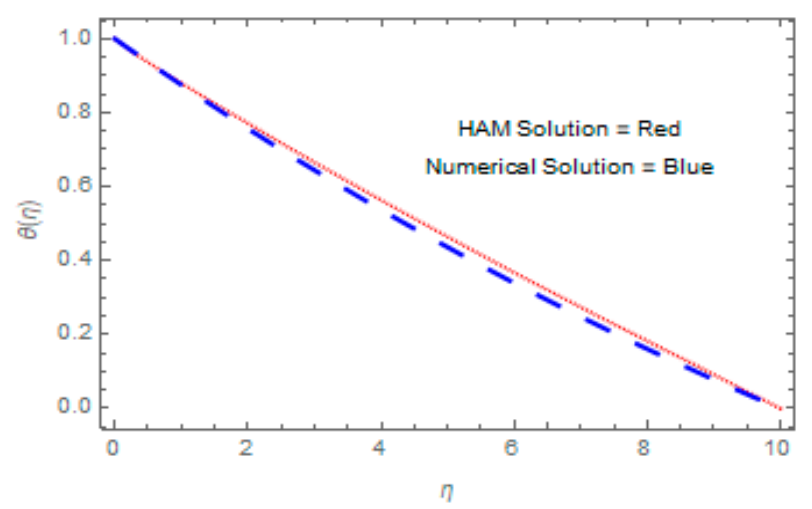
Figure 14. Comparison for sphere-shaped nanoparticles.